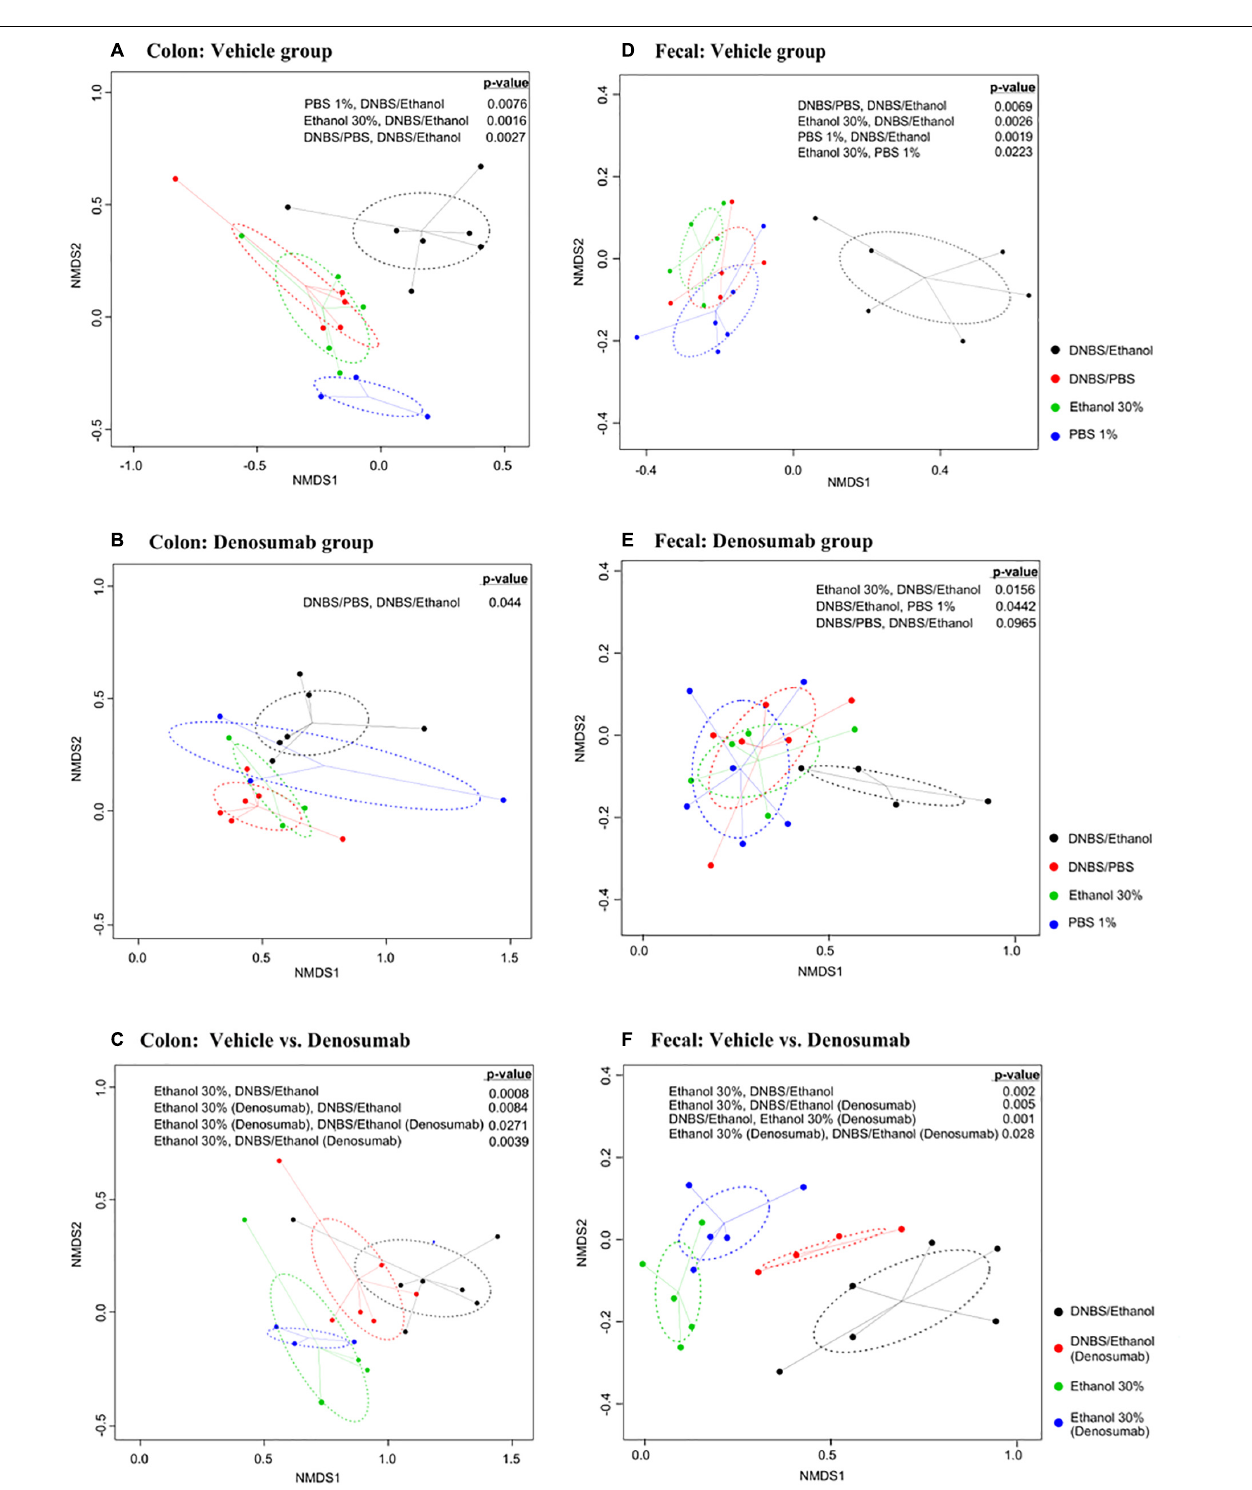
FIGURE 6 | Non-metric multidimensional scaling (nMDS) ordination plot, a measure of relative dissimilarities in the bacterial community composition in the colon mucosa and feces of (A,D) vehicle and (B,E) denosumab-treated mice; (C,F) comparison between two groups of denosumab and vehicle in DNBS/Ethanol vs. Ethanol treatments. The colored points are shaded according to different treatment groups. The p -values were calculated using PERMANOVA. For the multiple-comparison tests, only the significant p-values were included. Trends were discussed at p < 0.1.